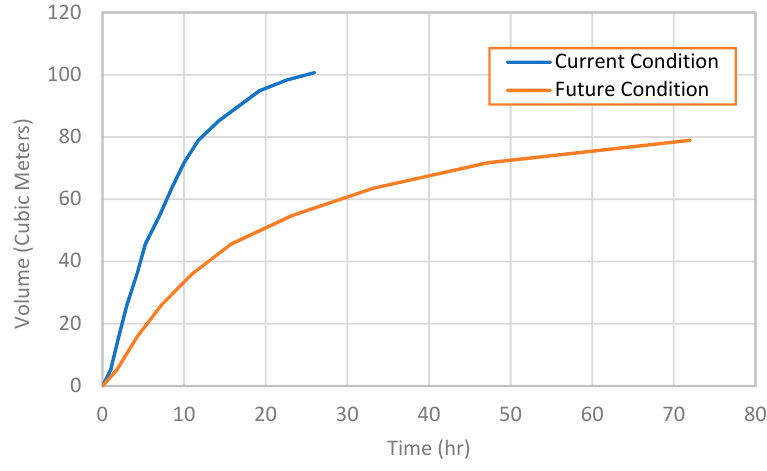
Figure 10. Recovered treatment volume for the current and future conditions. Water 2020 , 12 , x FOR PEER REVIEW